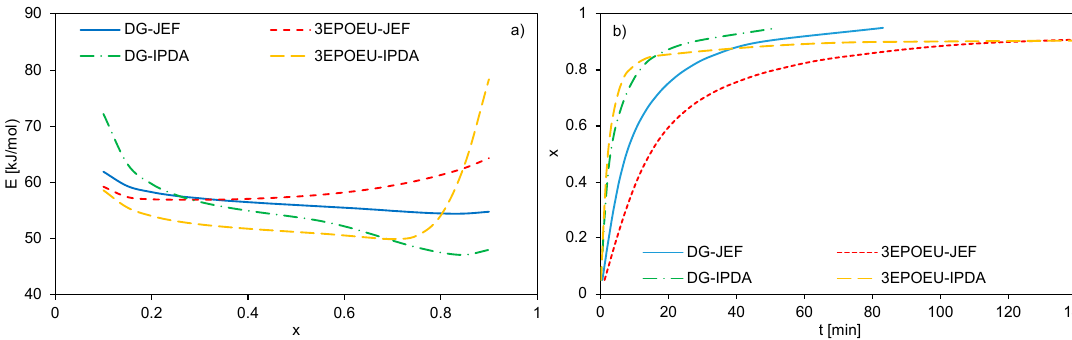
Figure 2. ( a ) Comparison of the activation energy E as a function of conversion x during dynamic curing of all formulations. ( b ) Conversion x as a function of the simulated reaction time at 120 °C obtained by the isoconversional analysis of nonisothermal experiments (simulations were performed from x = 0.05 to 0.95).